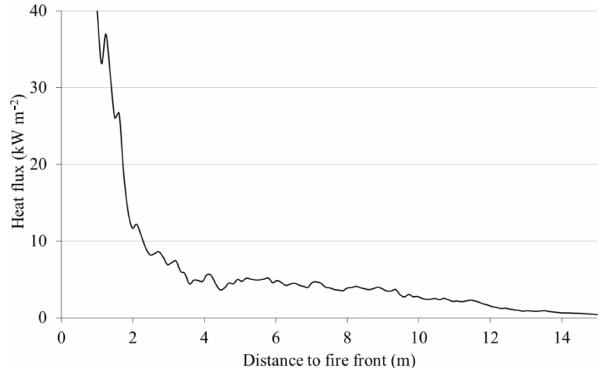
Figure 8. Comparison of experimental mass losses of the three species.